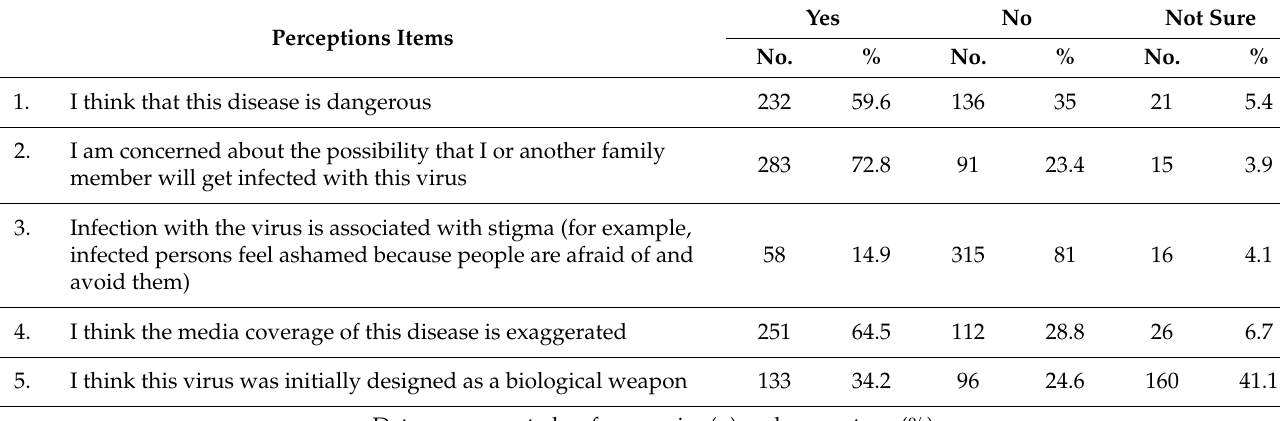
Table 4. Perception of the participants about COVID-19.